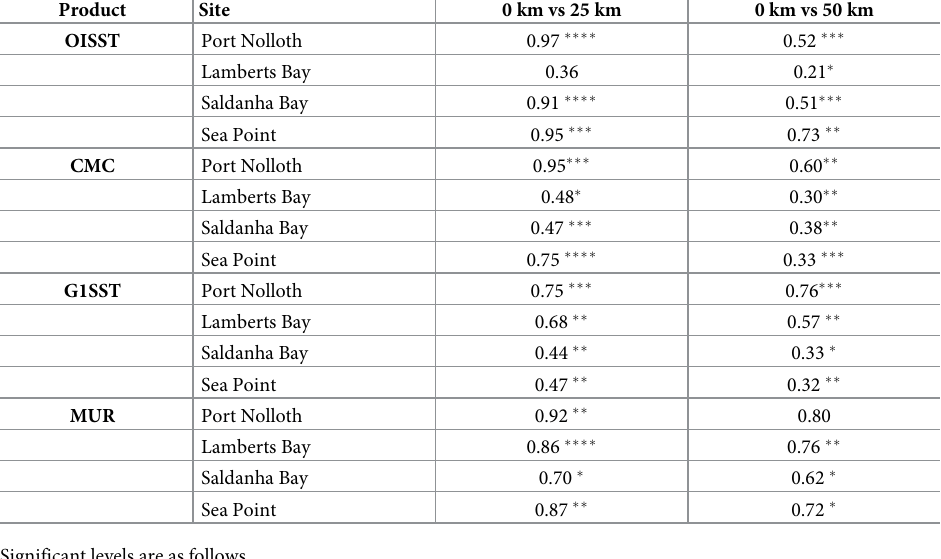
Table 2. A Pearson correlation of the relationship between the number of signals detected at 0 km versus a dis- tance of 25 km and between the number of signals at 0 km and 50 km. Product Site 0 km vs 25 km 0 km vs 50 km